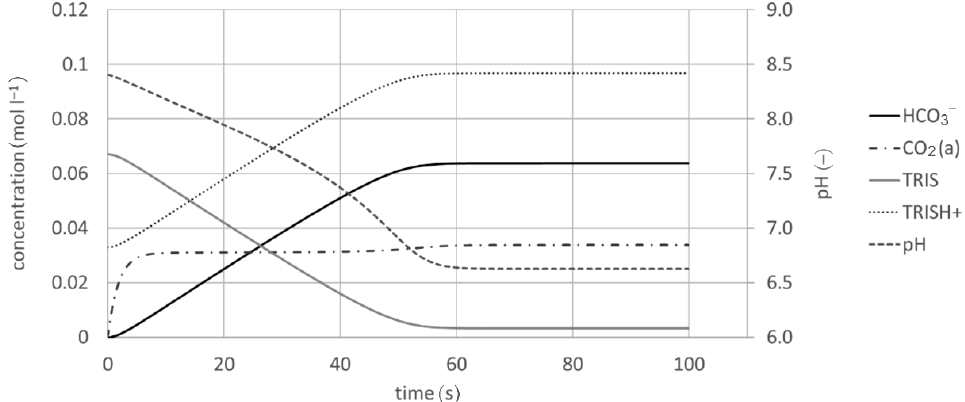
Figure 2. Example of model predictions. Course of the individual chemical species illustrating the linear increase in HCO 3 − over a certain time period.